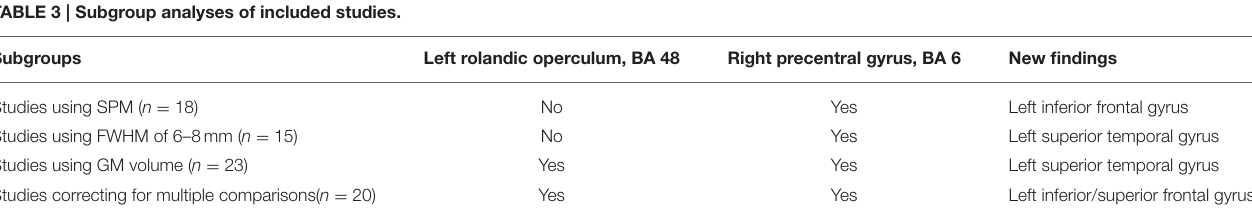
TABLE 3 | Subgroup analyses of included